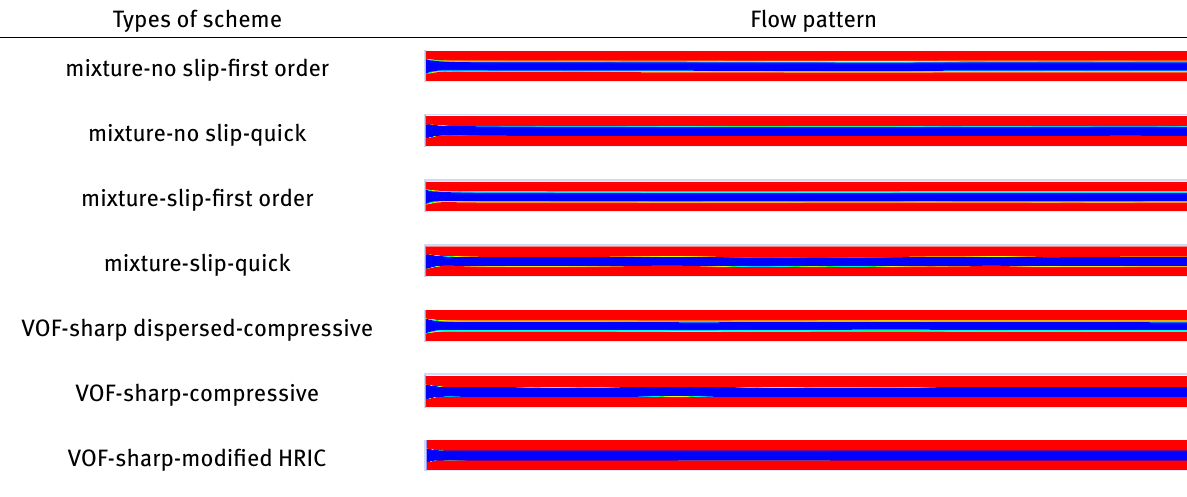
Table 12: Inlet the kerosene from the middle for two-phase flow patterns, (L = 2 m, H = 7.5 cm), mesh (780,000) Types of